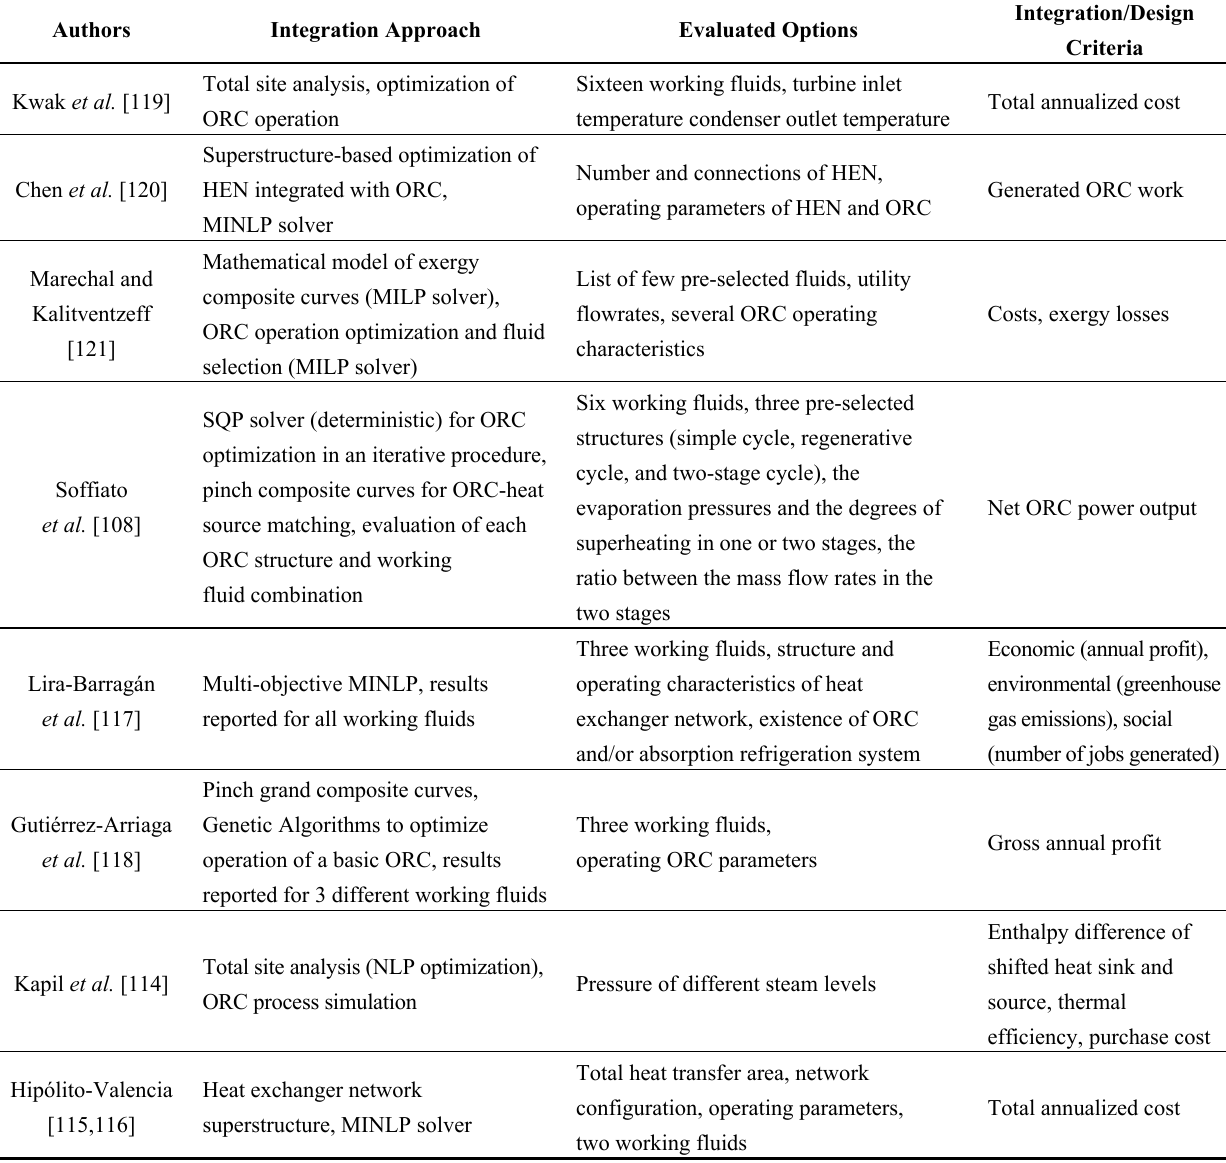
Table 10. Optimization-based heat source integration